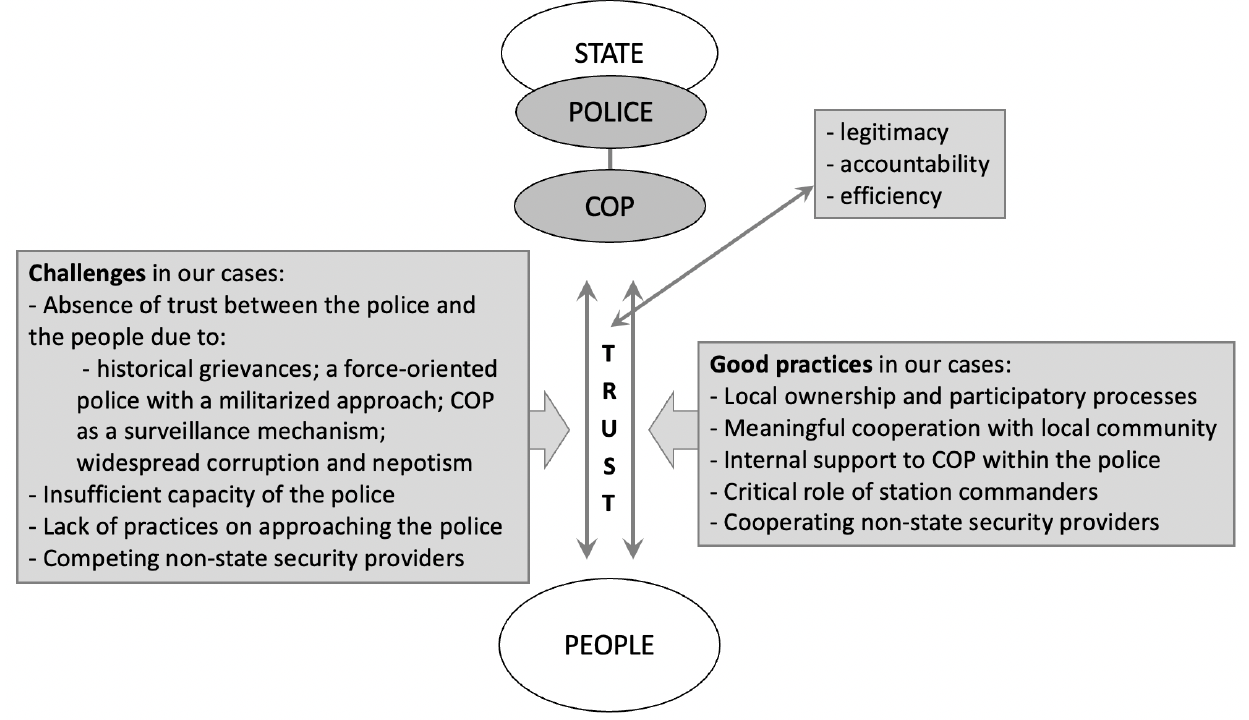
Figure 2. Challenges and good practices of